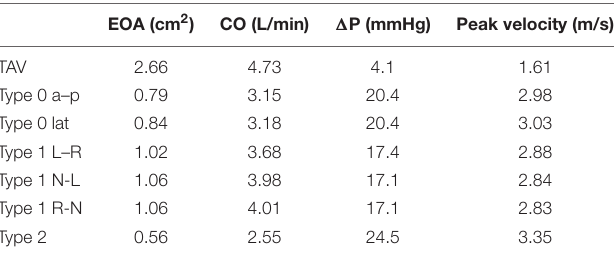
TABLE 3 | Hemodynamic results of TAV and BAV